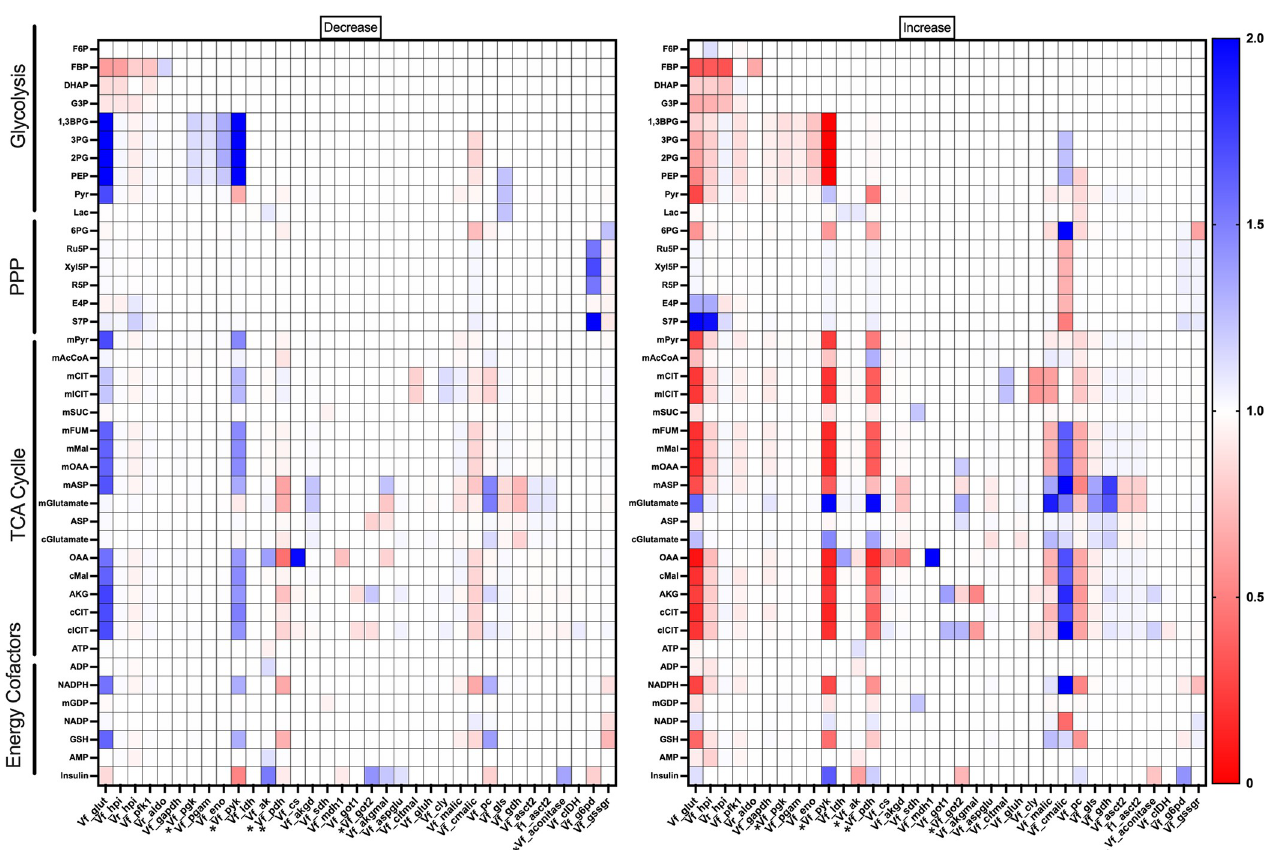
Fig 7. Effects of metabolic perturbations. We decreased (left) and increased (right) each reaction V max value ( y -axis) by a factor of two and assessed the impact on all metabolites and insulin ( x -axis). Metabolites and parameters that did not change or cause any changes, respectively, were excluded from the figure for better readability. The color bar indicates the effect of the perturbation relative to the base model with no perturbation. Parameter values which were found to be influential in the PLSR analysis are marked with a star.